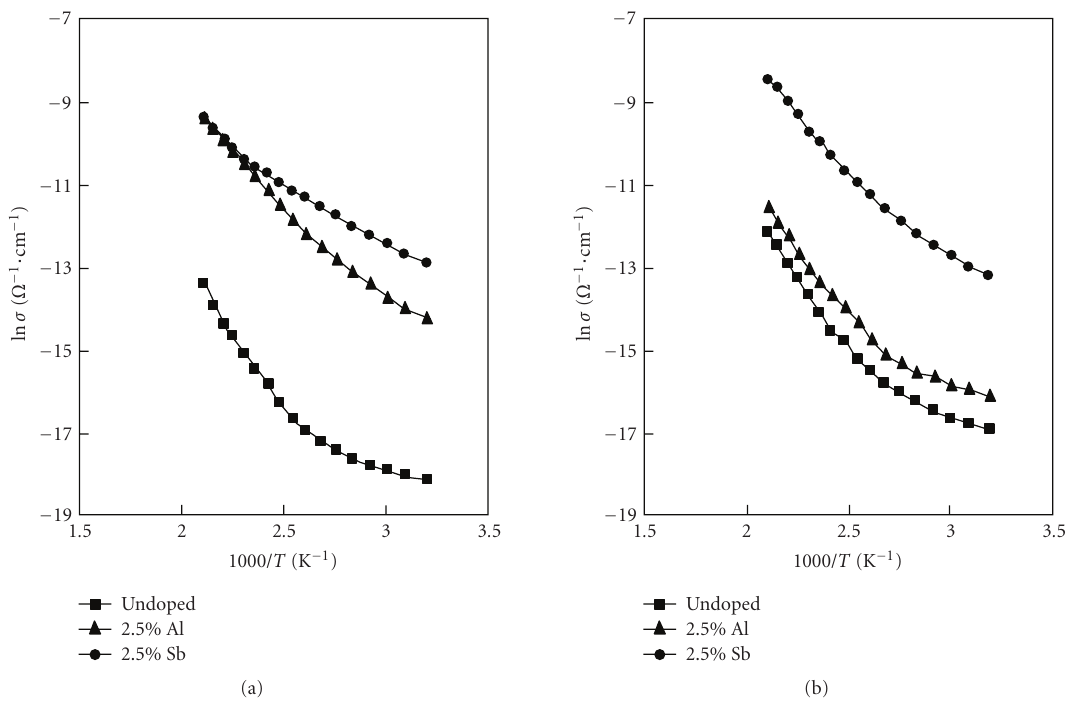
Figure 1: (a) T S = RT. (b) T S = 423